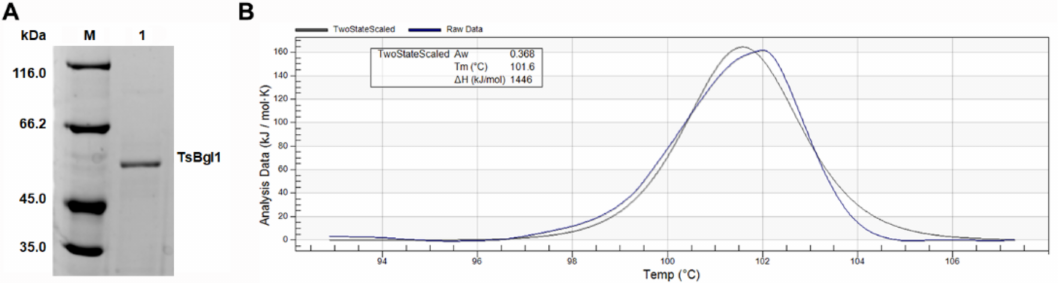
Figure 1. SDS-PAGE ( A ) and DSC ( B ) analysis of purified TsBgl1. M, standard protein marker. Lane 1, purified TsBgl1. Aw, water activity. Tm, melting temperature. ∆ H, enthalpy